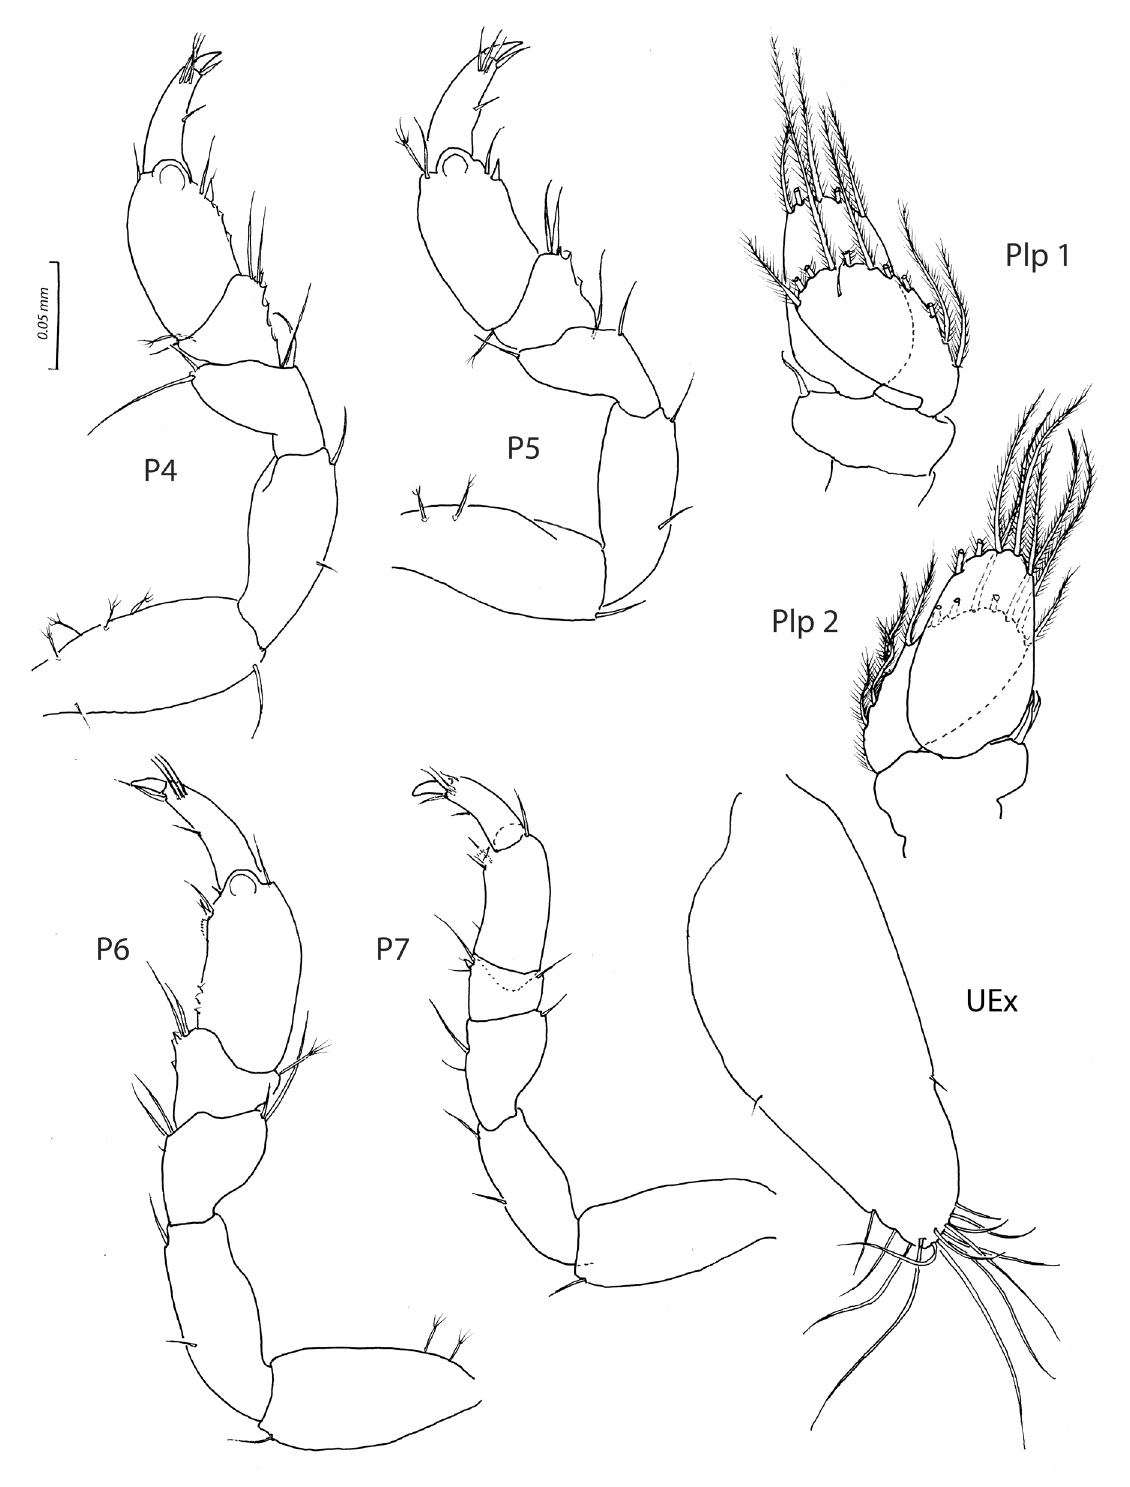
Fig. 8. Kupellonura indonesica sp. nov., holotype, immature adult (MZB Iso 100) . Abbreviations: P4– P7 = pereopods 4–7; Plp1–2 = pleopods 1–2; UEx = exopod of